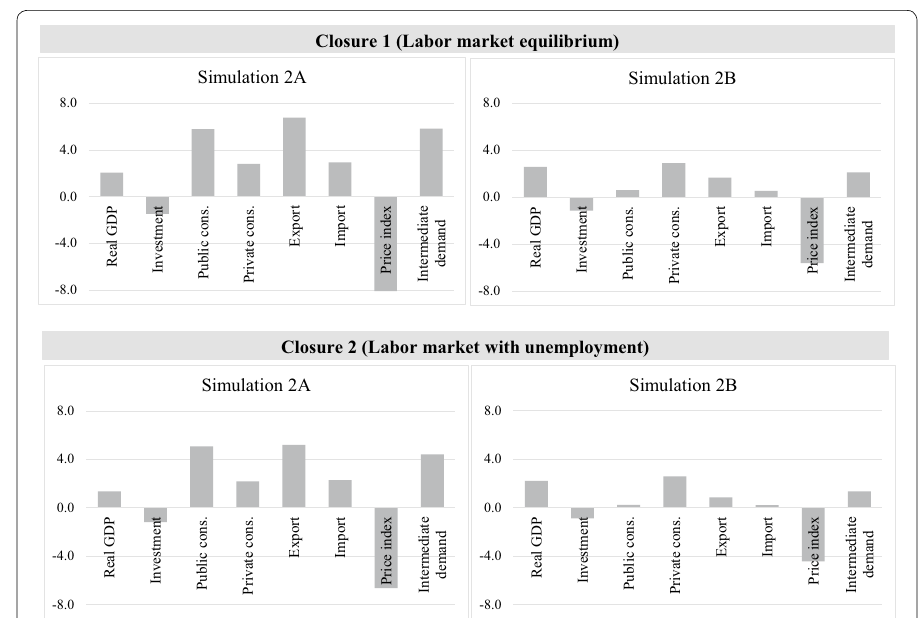
Fig. 5 Simulation results of productivity shocks (% change from base data). Source : Author’s